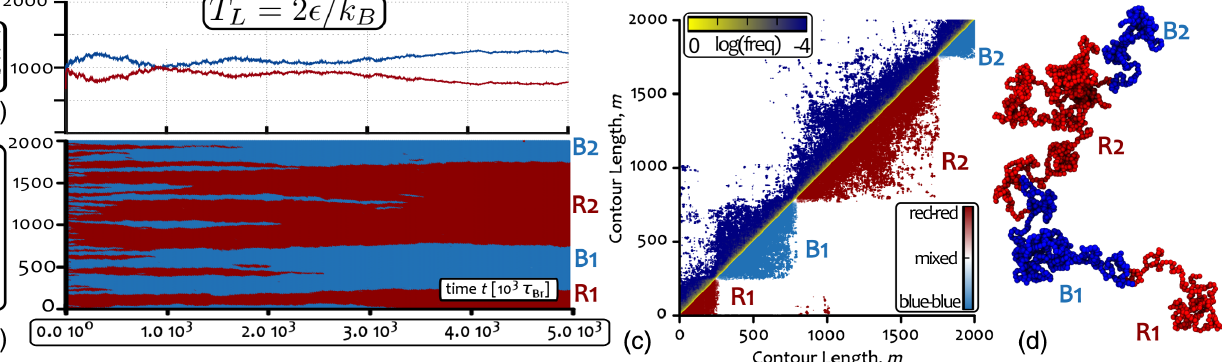
FIG. 7. Breaking detailed balance leads to the formation of TAD-like structures. Simulations correspond to M ¼ 2000 , 0 . 1 ϵ =k 2 ϵ =k 0 . 5 , see Ref. [54] for other cases). (a) Plot of the number of red (and blue) T T , T (i.e., α ¼ ϵ =k B L ¼ B B L ¼ Rec ¼ q; t Þ as a function of time. Notice that these curves do not seem to diverge within the simulation runtime, opposite to colored beads N b ð the ones reported in the previous sections. (b) The kymograph of the system showing the presence of long-lived boundaries between distinct epigenetic domains. (c) A contact map averaged over the last 2 10 5 Brownian times: The upper half shows the contact probability between beads; the lower half is color-coded to separately show the probability of red-red, blue-blue, and mixed contacts. (d) A snapshot of the 3D configuration. The visible TAD-like structures in the snapshot and in the contact map are enumerated as in the kymograph, to ease comparison. Note that the TAD-like structures are long-lived but metastable, while they coarsen on very long time scales. More details are given in the text and Ref. [54], and other values of T are given in Figs. S14 and S15, as well as different initial L conditions in Fig. S16. See also